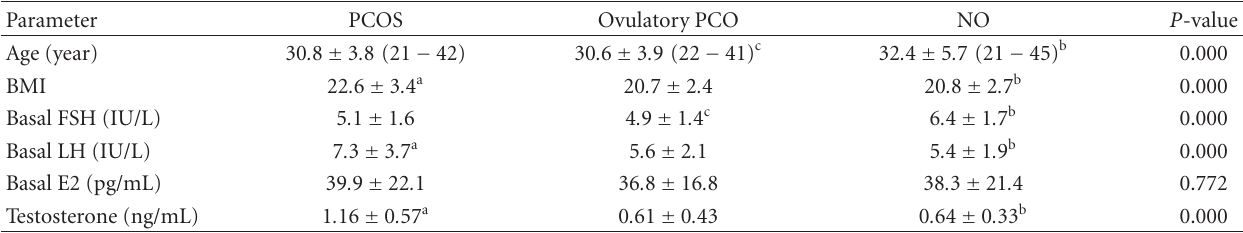
Table 1: Comparisons of basic clinical features (mean ± SD).